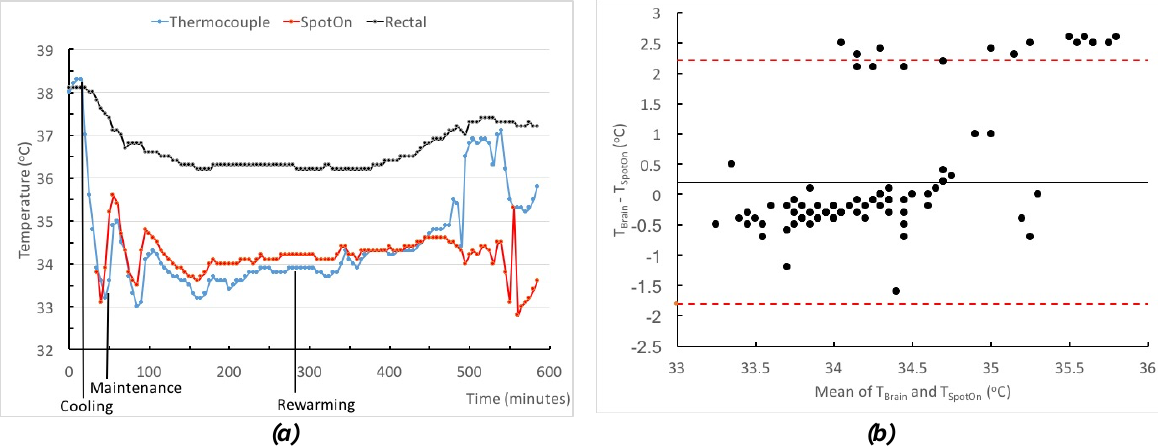
Figure 3. (a) Measured brain, rectal and esophageal temperature over time during baseline, cooling and rewarming phase. Brain data were obtained from thermocouple needle probe and SpotOn temperature monitoring system above the eye on the forehead (location #3). (b) Bland-Altman plot of two brain temperature methods. The dotted line shows the mean difference and dash-dotted lines show the limits of agreement (mean ± 2 SD).